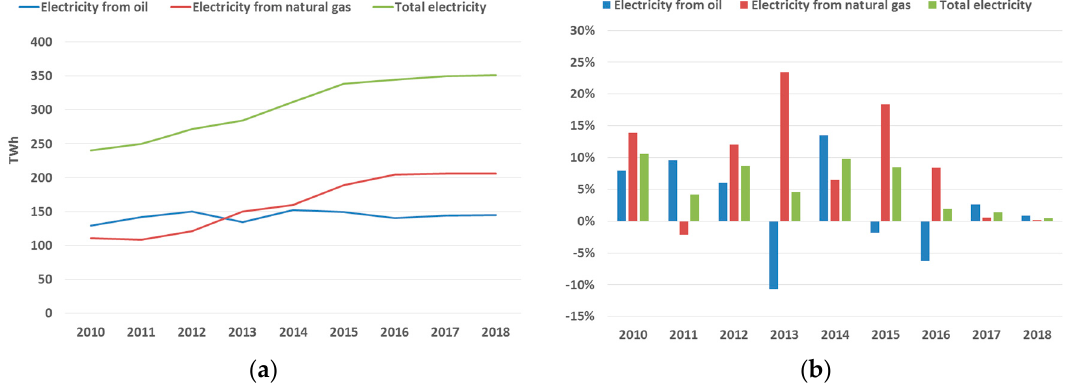
Figure 14. Fuel inputs to electrical generation ( a ) absolute ( b ) percentage change year on year (2000– 2018). Source: Authors based on